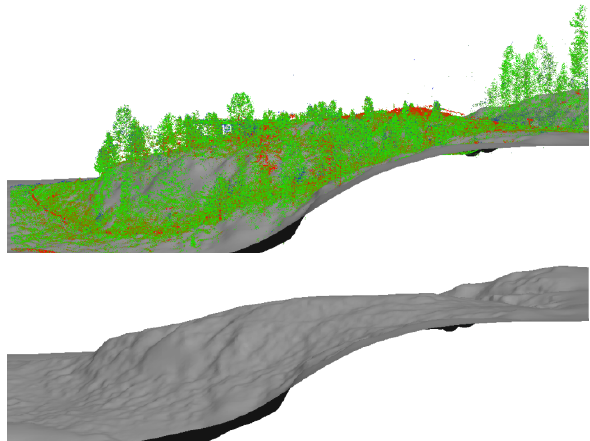
Figure 5. Classified vegetation in terrestrial laser scanning point